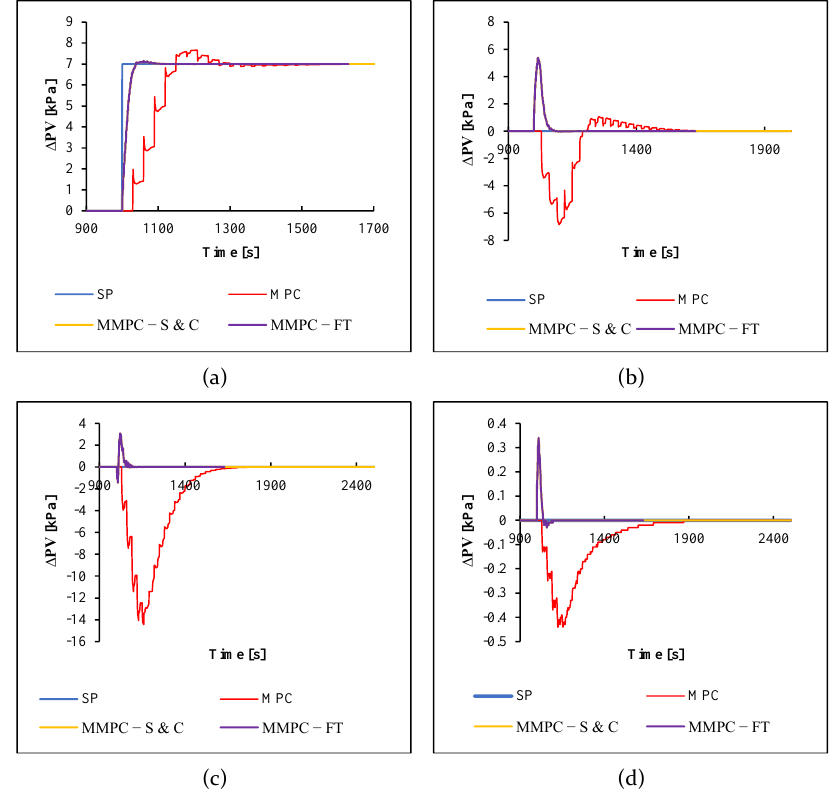
Figure 3. Comparison of controller performance with SP changes on the compressor unit 1 (MIMO Model 1) on: ( a ) compressor unit 1; ( b ) compressor unit 2; ( c ) compressor unit 3; and ( d ) compressor unit 4.